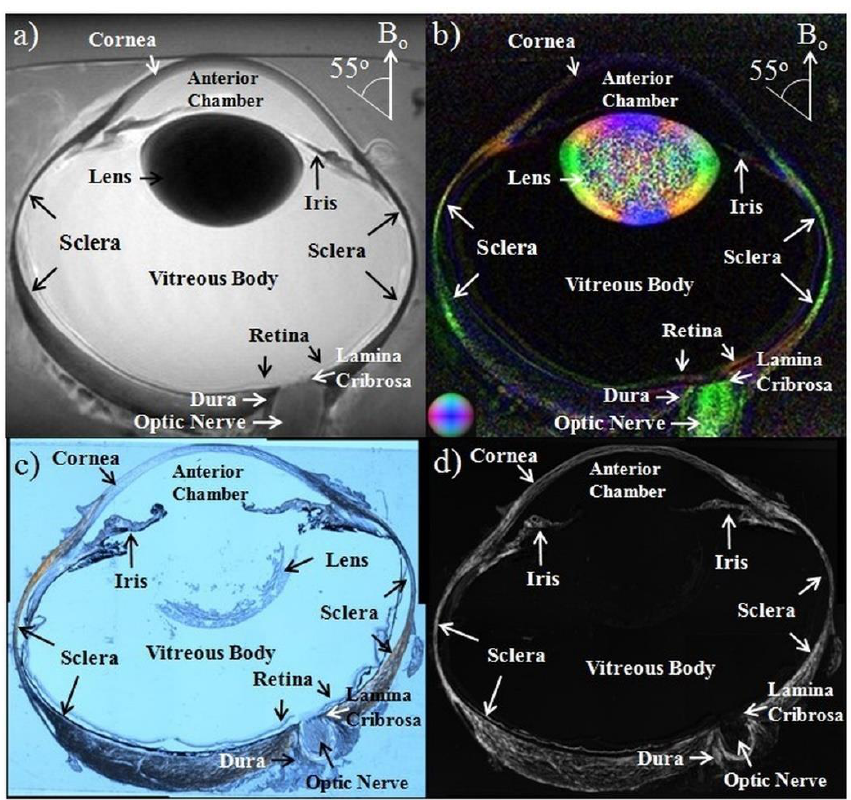
Figure 4. Whole ovine eye images acquired with T2-weighted MRI ( a ) , color-encoded DTI mapping for fractional anisotropy ( b ) , polarized light microscopy of a histological section ( c ), and intensity mapping of collagen density ( d ). Colors in ( b ) correspond to principal diffusional directions: caudal- rostral (blue), dorsal-ventral (green) and left-right (red). Images are adapted with permission from Ho et al. [73].